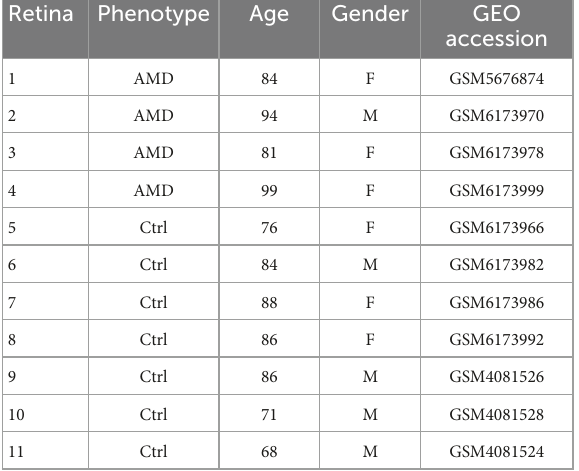
TABLE 1 Details of human retinal